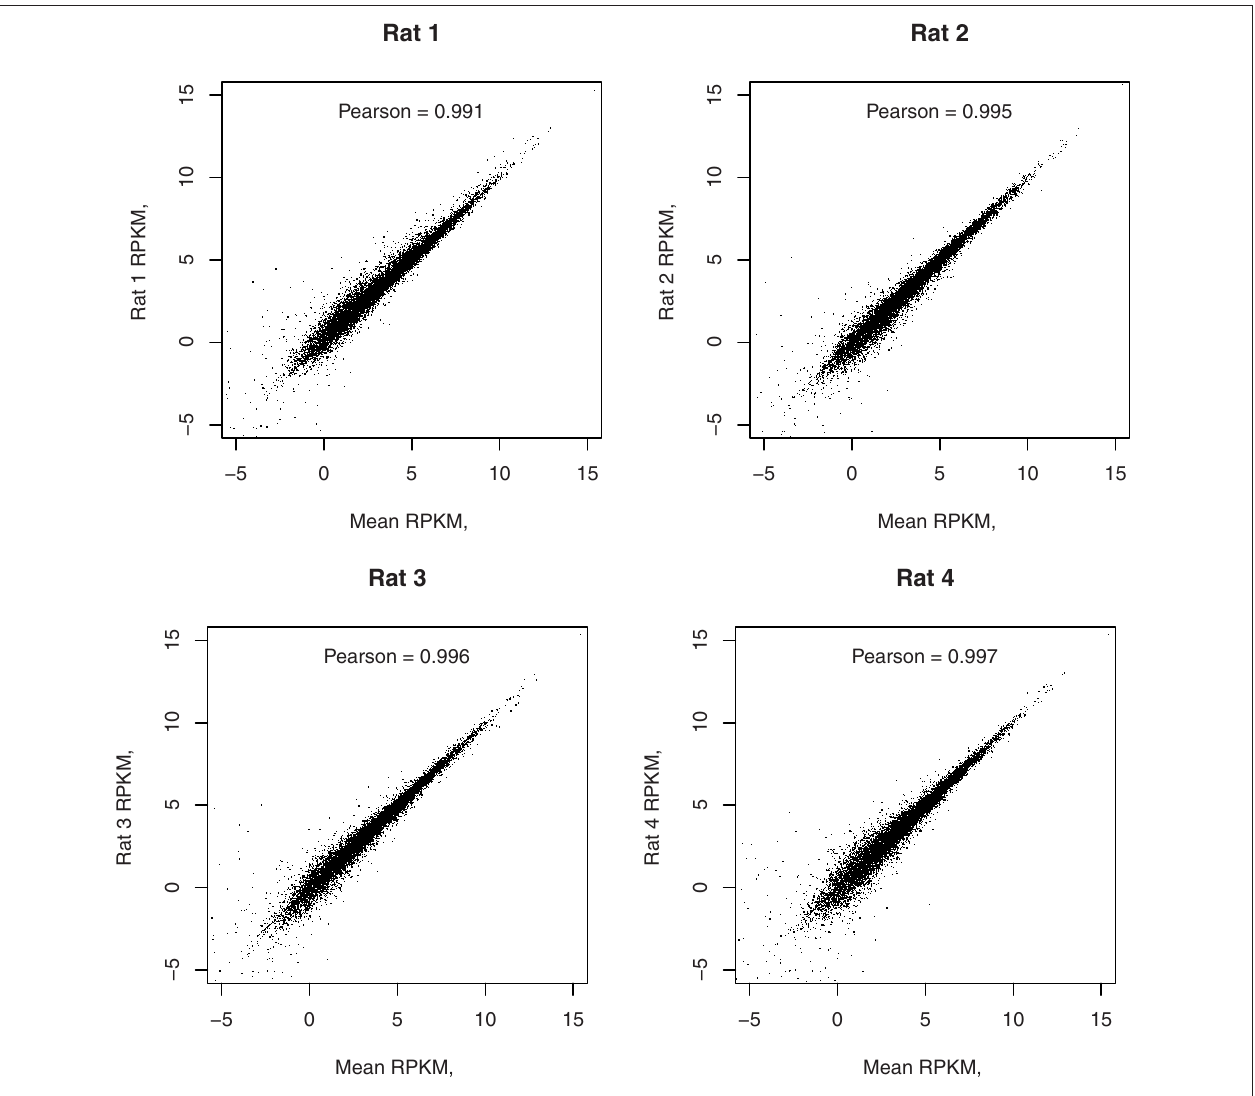
FiGuRe 5 | Correlation of each RNA-seq sample with the mean of all samples. The correlation coefficients between the gene expression levels from each rat and the mean expression levels of the four rats are reported in their respective graphs. The high correlation demonstrated the reliability of detection of